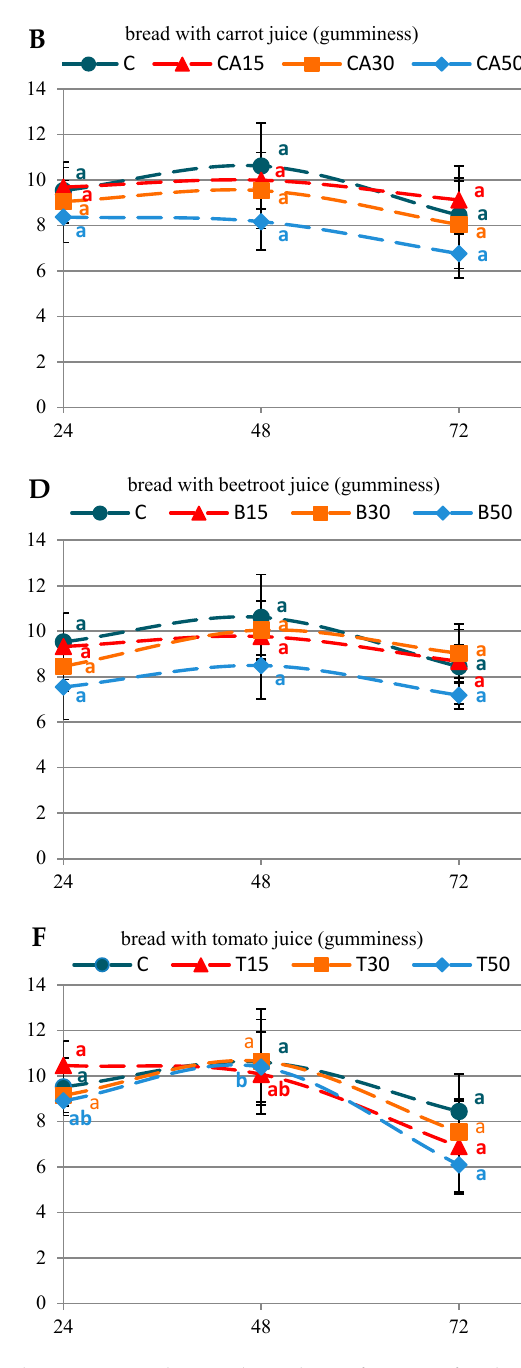
Figure 2. Crumb hardness [N] and gumminess during three days of storage for the experimental bread made with the formulation without (C) or with carrot (CA) juice (( A ) hardness; ( B ) gumminess); beetroot (B) juice (( C ) hardness; ( D ) gumminess); tomato (T) juice (( E ) hardness; ( F ) gumminess). Points represent means ± standard deviation, ( n = 6, for each bread type). The values within each type of bread marked with different letters are significantly different ( p <